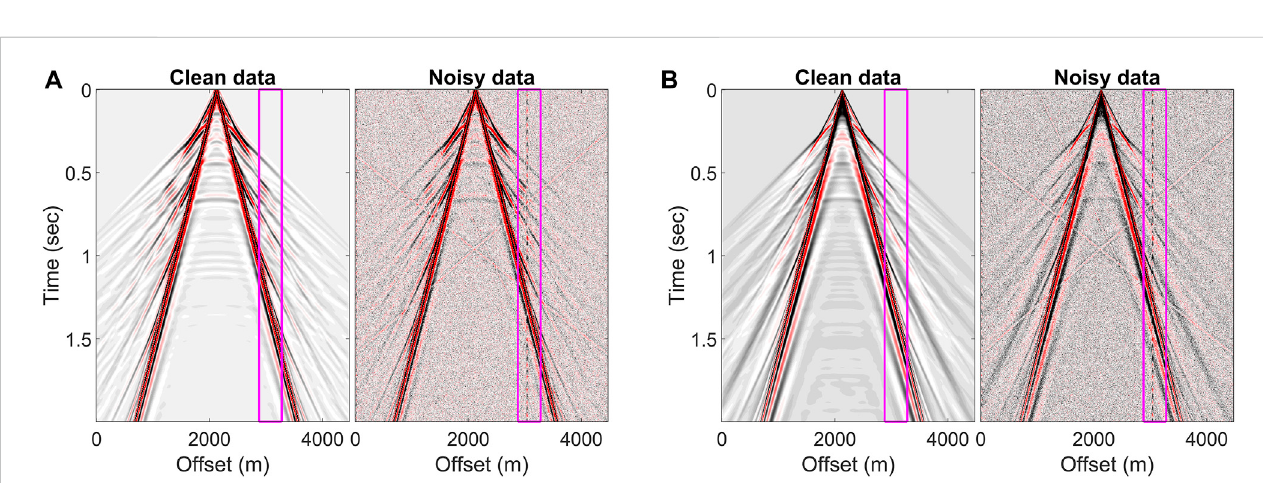
FIGURE 7 Syntheticdatapairsforthelimitationtest.Waveformmodelingwascalculatedusingthe (A) Rickerwaveletand (B) sine-cubedwavelet.Thenoisetypesin noisy data include Gaussian noise, coherent noise in the magenta boxes, three linear noises, and spike